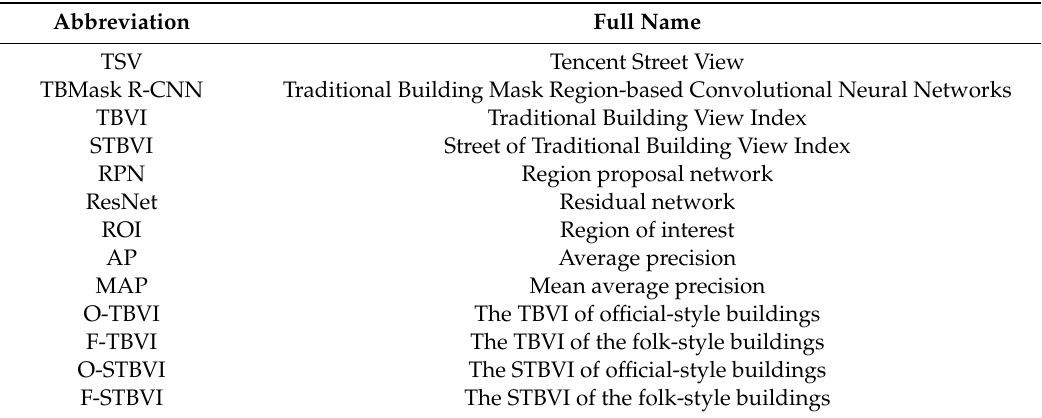
Table 3. List of